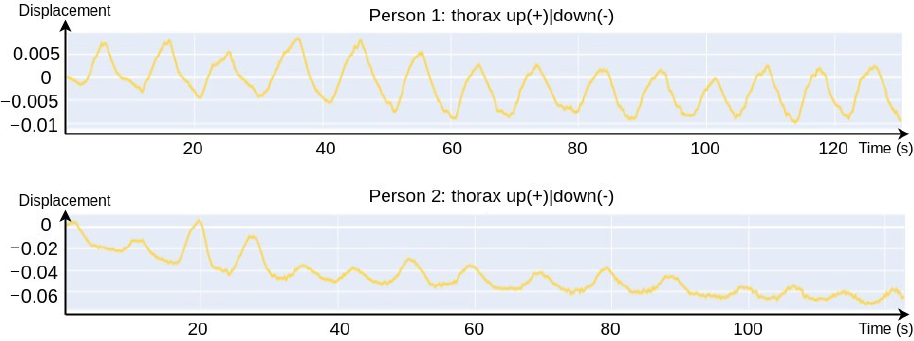
Figure 5. Thorax movement graphs of two people during